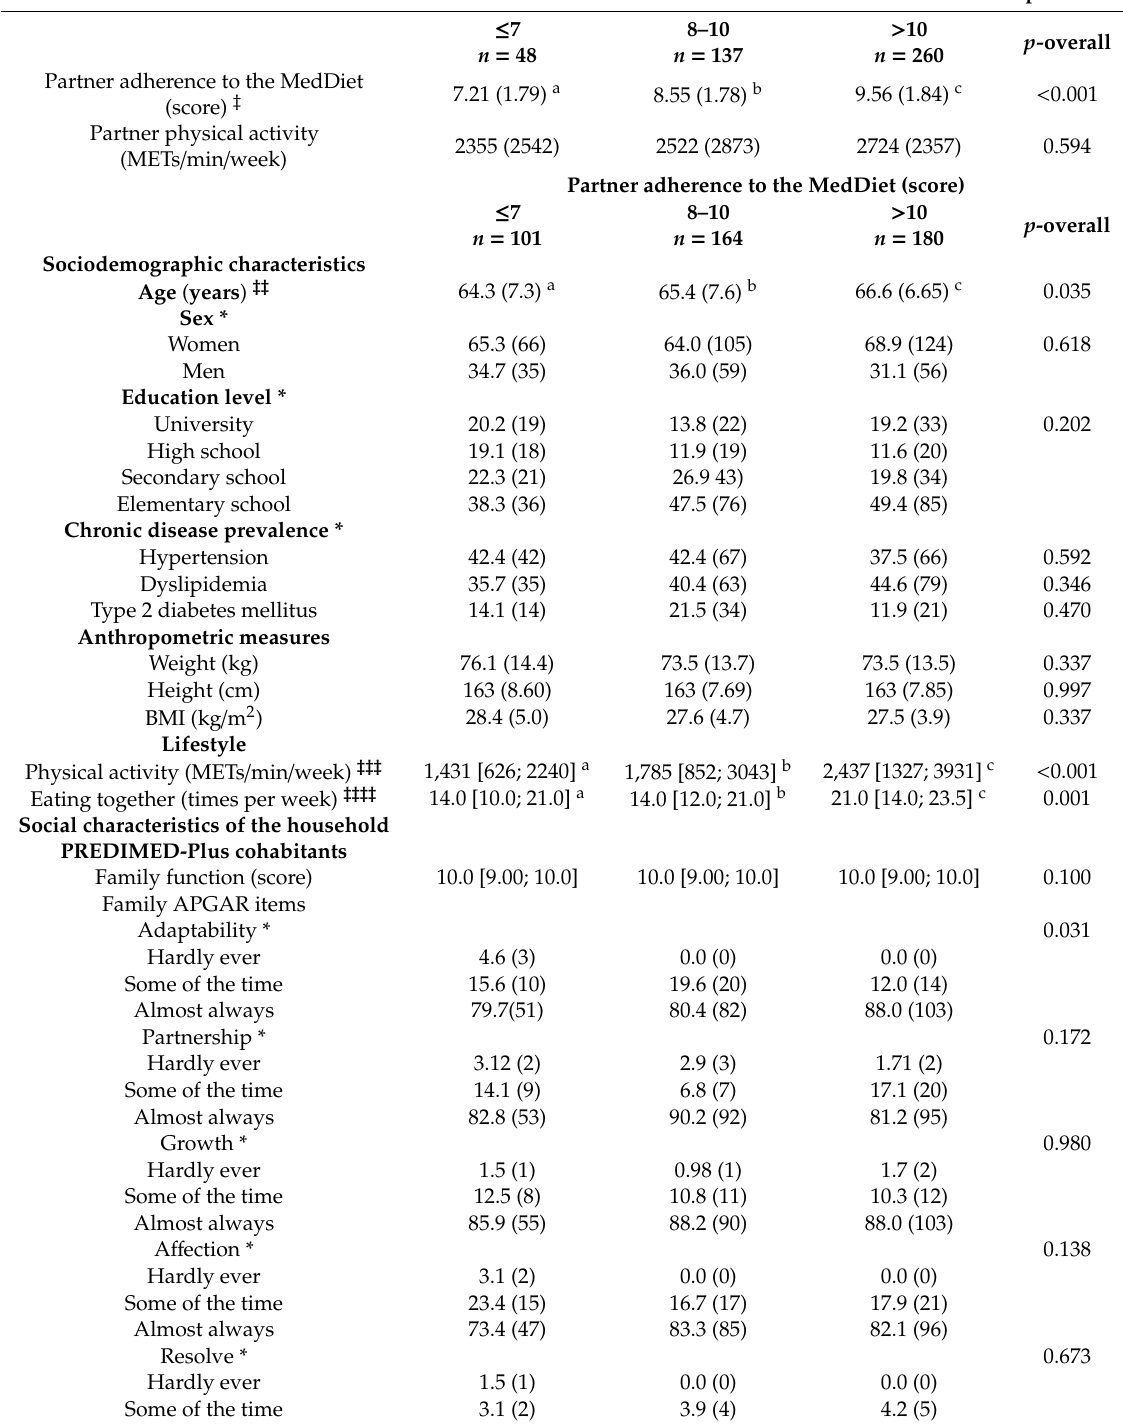
Table 2. General characteristics of the household PREDIMED-Plus cohabitants according to Mediterranean diet adherence